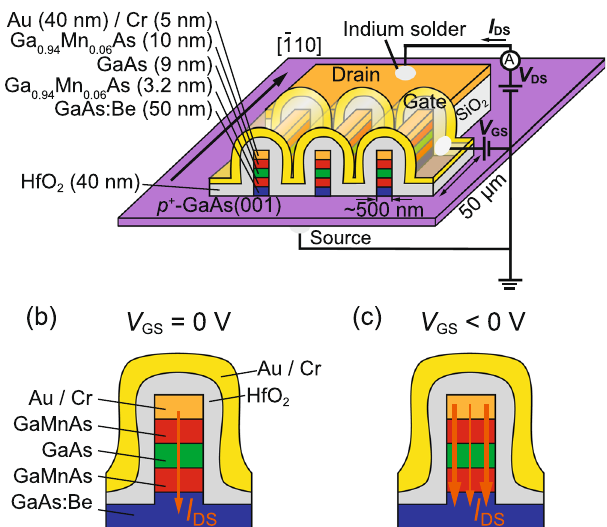
Figure 1. ( a ) Schematic illustration of the vertical spin MOSFET investigated in this study. The backside of the substrate is the source electrode, the comb shaped Au/Cr layer is the drain electrode and the Au/Cr layer above the HfO 2 layer is the gate electrode. ( b , c ) Schematic device operation of our vertical spin MOSFET when a gate voltage V GS is not applied ( b ) and when a negative gate voltage is applied ( c ). The orange arrows represent a drain-source current I DS